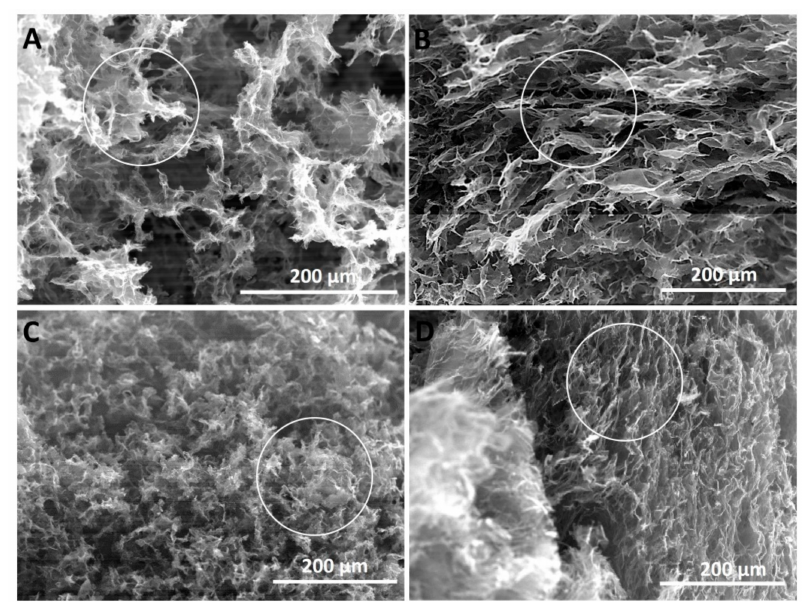
Figure 3. SEM images of GO and GOx with 1:8 GO:VC @ 65C@2 h ( A , B ) and 1:2.5 GO:VC @ 120C@12 h ( C , D ).